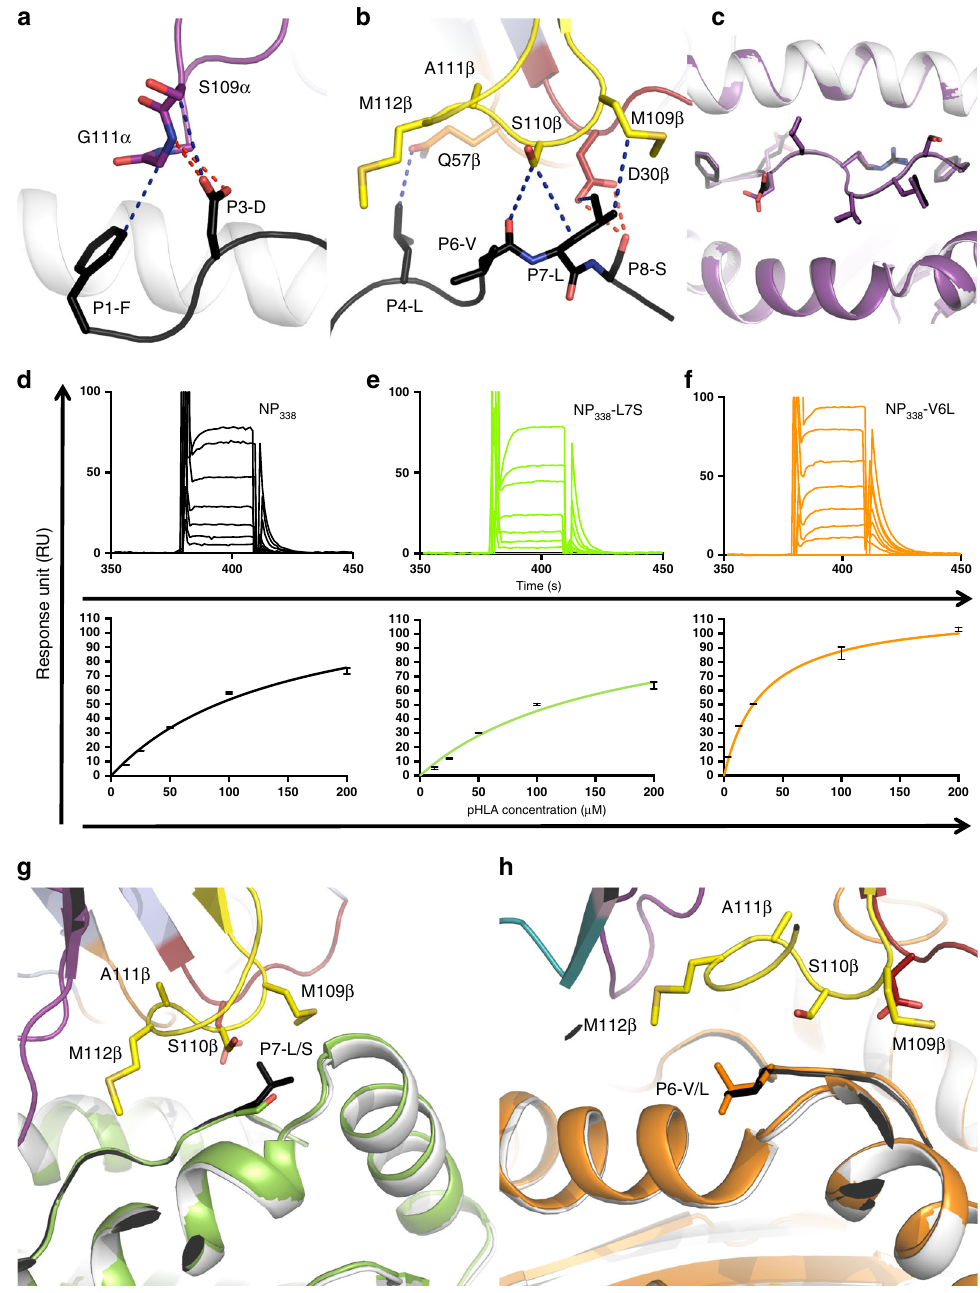
Fig. 7 EM2 TCR recognizes the structurally similar NP 338 variants. a Interaction between the EM2 TCR CDR3 α loop (purple) with the NP 338 peptide (black). b Interaction of the NP 338 peptide (black) with the CDR1 β (red), CDR2 β (orange), and the CDR3 β loops (yellow). The blue and red dashed lines indicate Van der Waals or hydrogen bonds, respectively. c Top view of the structural overlay of the HLA-B37-NP 338 free (purple) or bound to the EM2 TCR (white for HLA and black for the peptide). d – f Surface plasmon resonance sensorgrams (top panel) and equilibrium binding curves (bottom panel) of the EM2 TCR for the HLA-B37 presenting the NP 338 ( d , in black), NP 338 -L7S ( e , in green), or NP 338 -V6L ( f , in orange). The experiment was done twice in duplicate. g Overlay of the EM2 TCR-HLA-B37-NP 338 (HLA in white and peptide in black) with the HLA-B37-NP 338 -L7S (green) structures. The EM2 TCR is colored as per Fig. 6, with the CDR3 β loop in yellow. h Overlay of the EM2 TCR-HLA-B37-NP 338 (HLA in white and peptide in black) with the HLA-B37-NP 338 -V6L (orange) isolated from Donor 1 could recognize both NP 44 variants, while the remainder of the repertoire was variant speci fi c (Fig. 8b). NP 44 variant speci fi c. We previously solved the structures of both NP 44 and NP 44 -S7N peptides in complex with the HLA-A1 molecule 23 . In similar fashion as HLA-B37 and the NP 338 var-